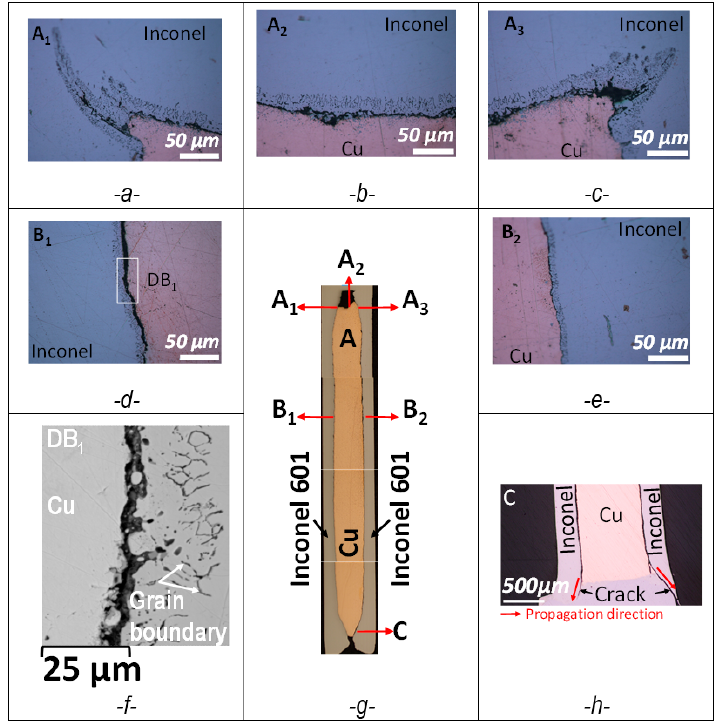
Figure 6. Samples prepared with oil, interface damage (after heat treatment), and consequent cracking (after welding and bending): optical and SEM (Scanning Electron Microscopy) observations of damage close to the Cu–Inconel 601 interface. ( g ) Overall view of the sample. ( a – f ) Correspond to a sample after heat treatment (prior to welding and bending) and ( h ) corresponds to another sample (after bending). ( a – c ) Copper–Inconel 601 interface in regions (A 1 , A 2 , A 3 ), ( d – e ) copper–Inconel 601 interface in regions (B 1 , B 2 ). ( f ) SEM observation of the interface in region B 1 . ( h ) Optical observation of the interface in region C after welding and bending with crack propagation through the Inconel 601.